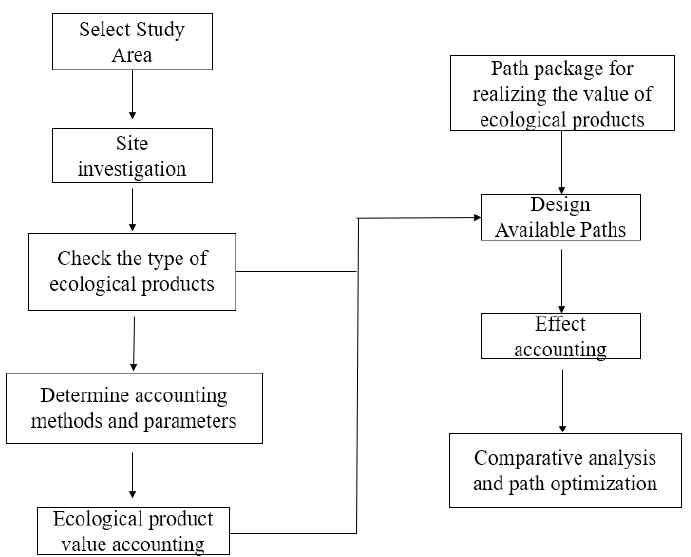
Figure 1. Technical Process.